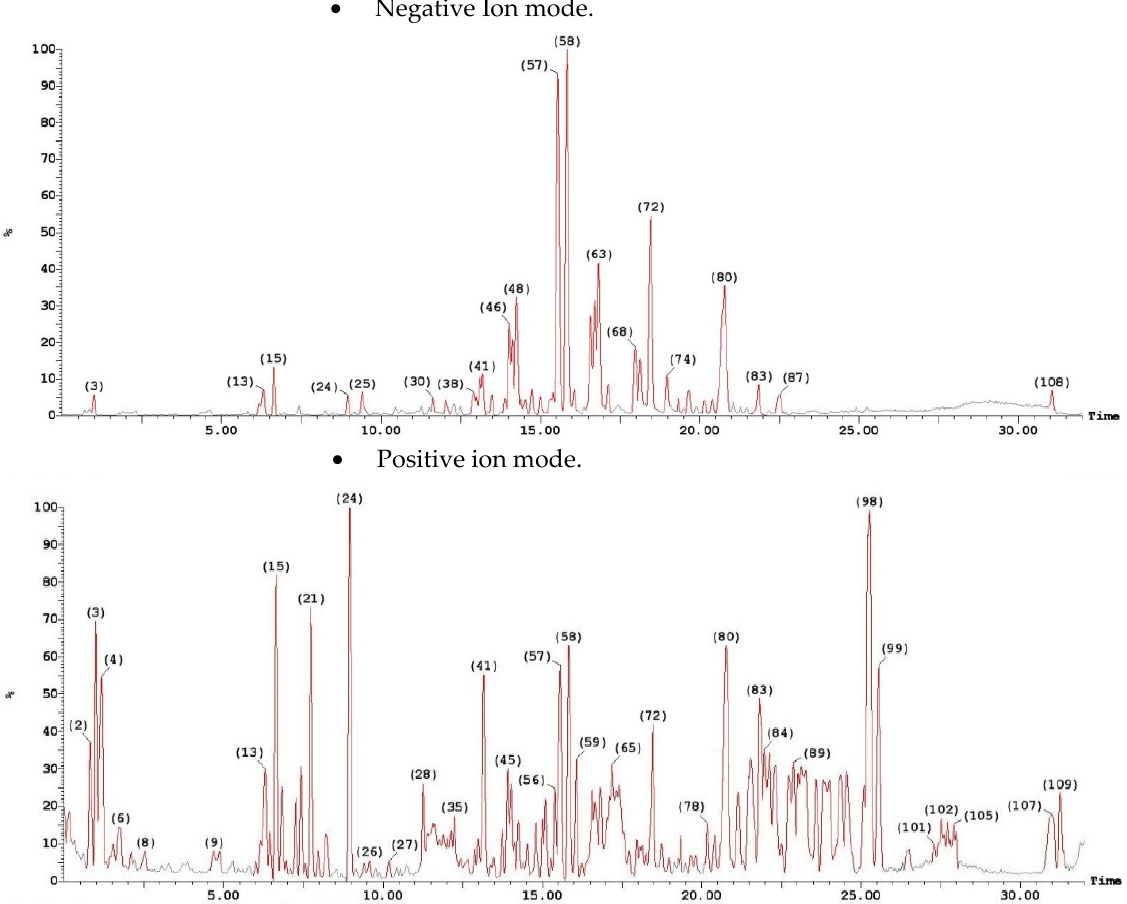
Figure 1. A cell free ethyl acetate extract run on both ESI-MS positive and negative ion mode for antibiotic detection from the isolate A. faecalis isolate MZ921504 using XEVO TQD triple quadrupole instrument.